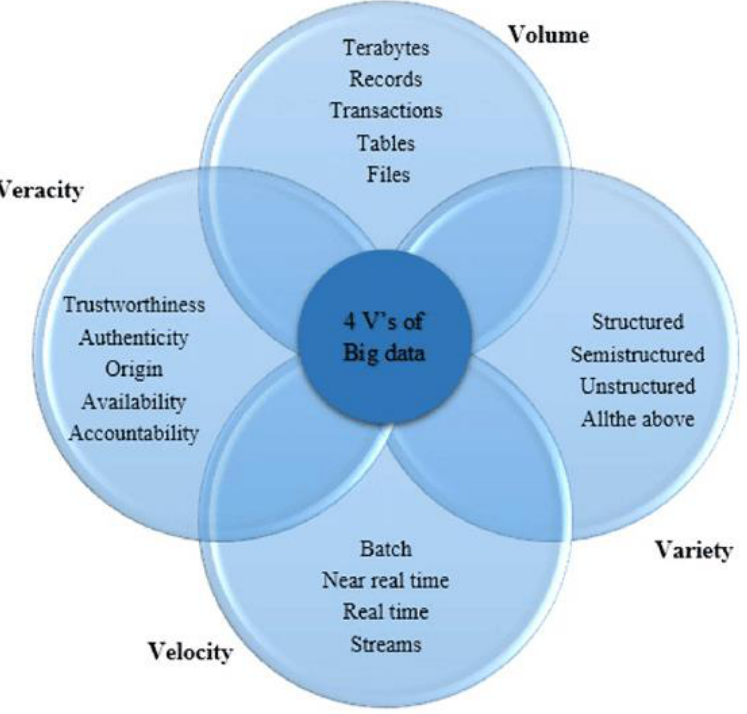
Fig. 1 Big data’s four Vs in